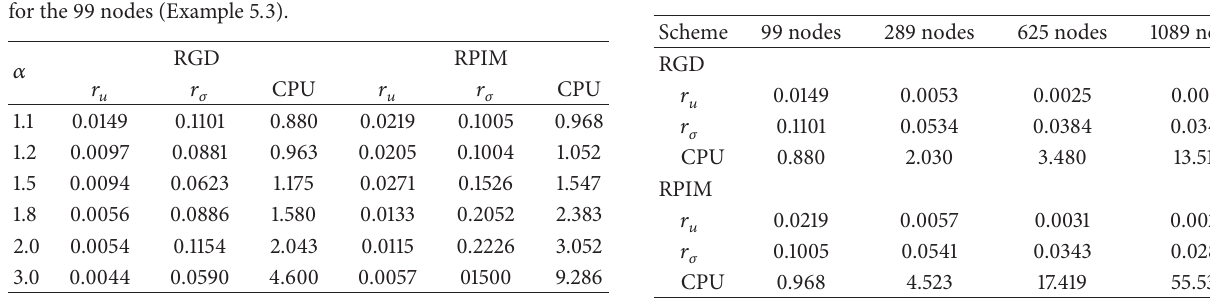
Table 9: Convergence study for Example 5.3